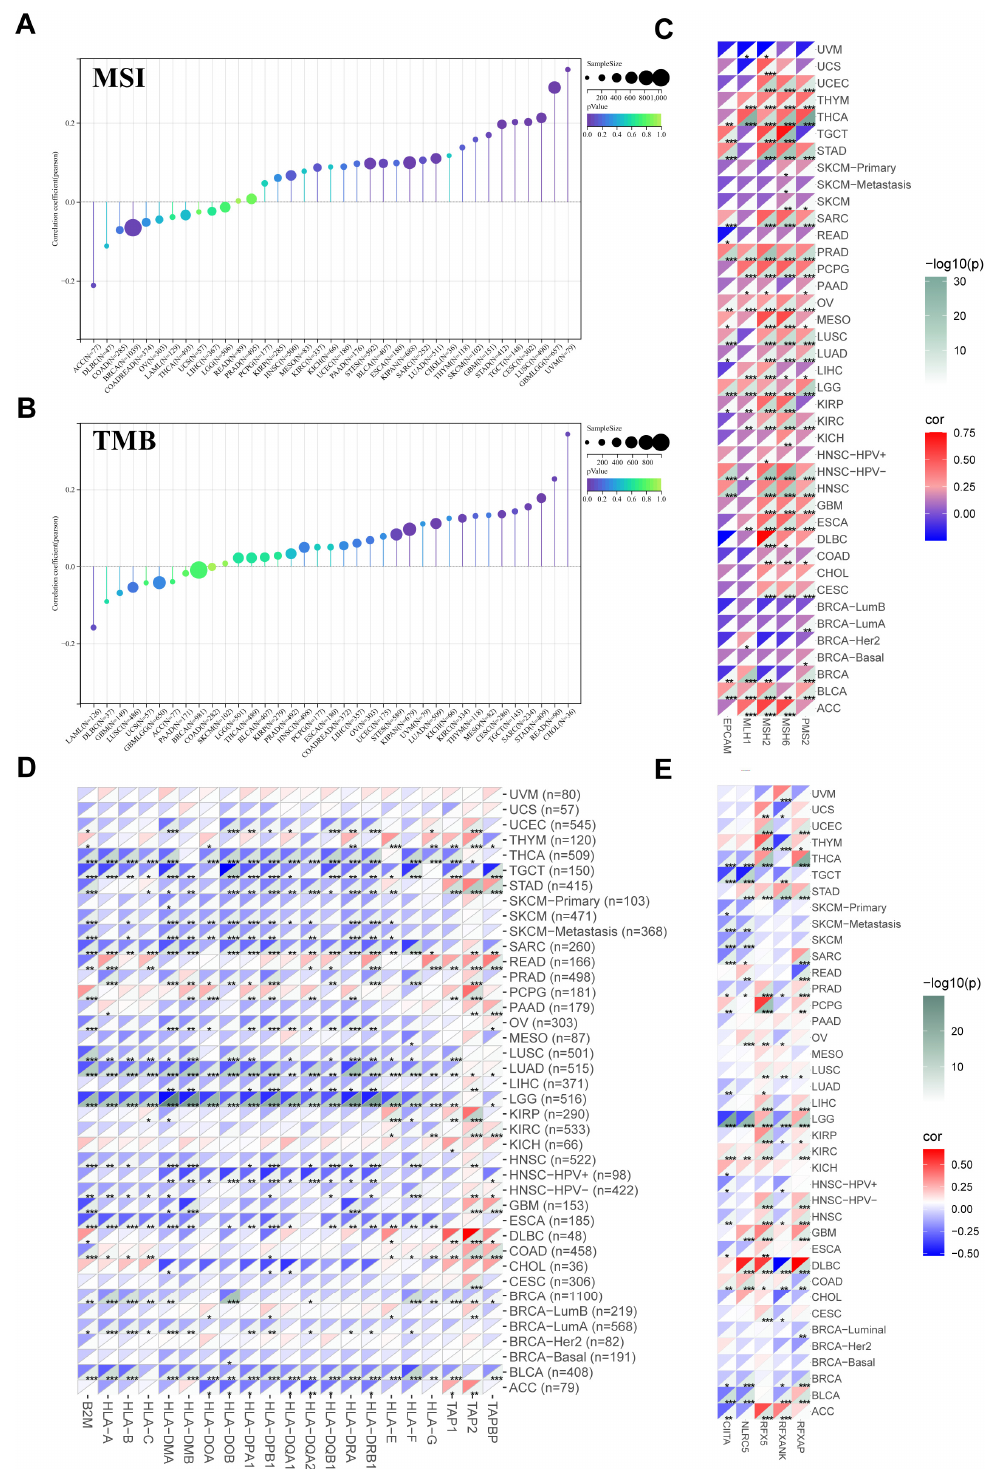
Figure 5. Correlation analysis of FASN expression with TMB, MSI, MMR-related genes, MHCs, and transcription factors. Sangerbox3.0 online website was used to analyze the relationship between FASN mRNA expression and MSI ( A ) and TMB ( B ). Using timer2.0 to analyze the correlation between FASN mRNA expression and MMRs (EPCAM, MLH1, MSH2, MSH6, PMS2) ( C ), MHCs ( D ), CITTA, RFX5, RFXANK, and RFXAP ( E ) in multiple cancers. (* p < 0.05, ** p < 0.01, *** p <